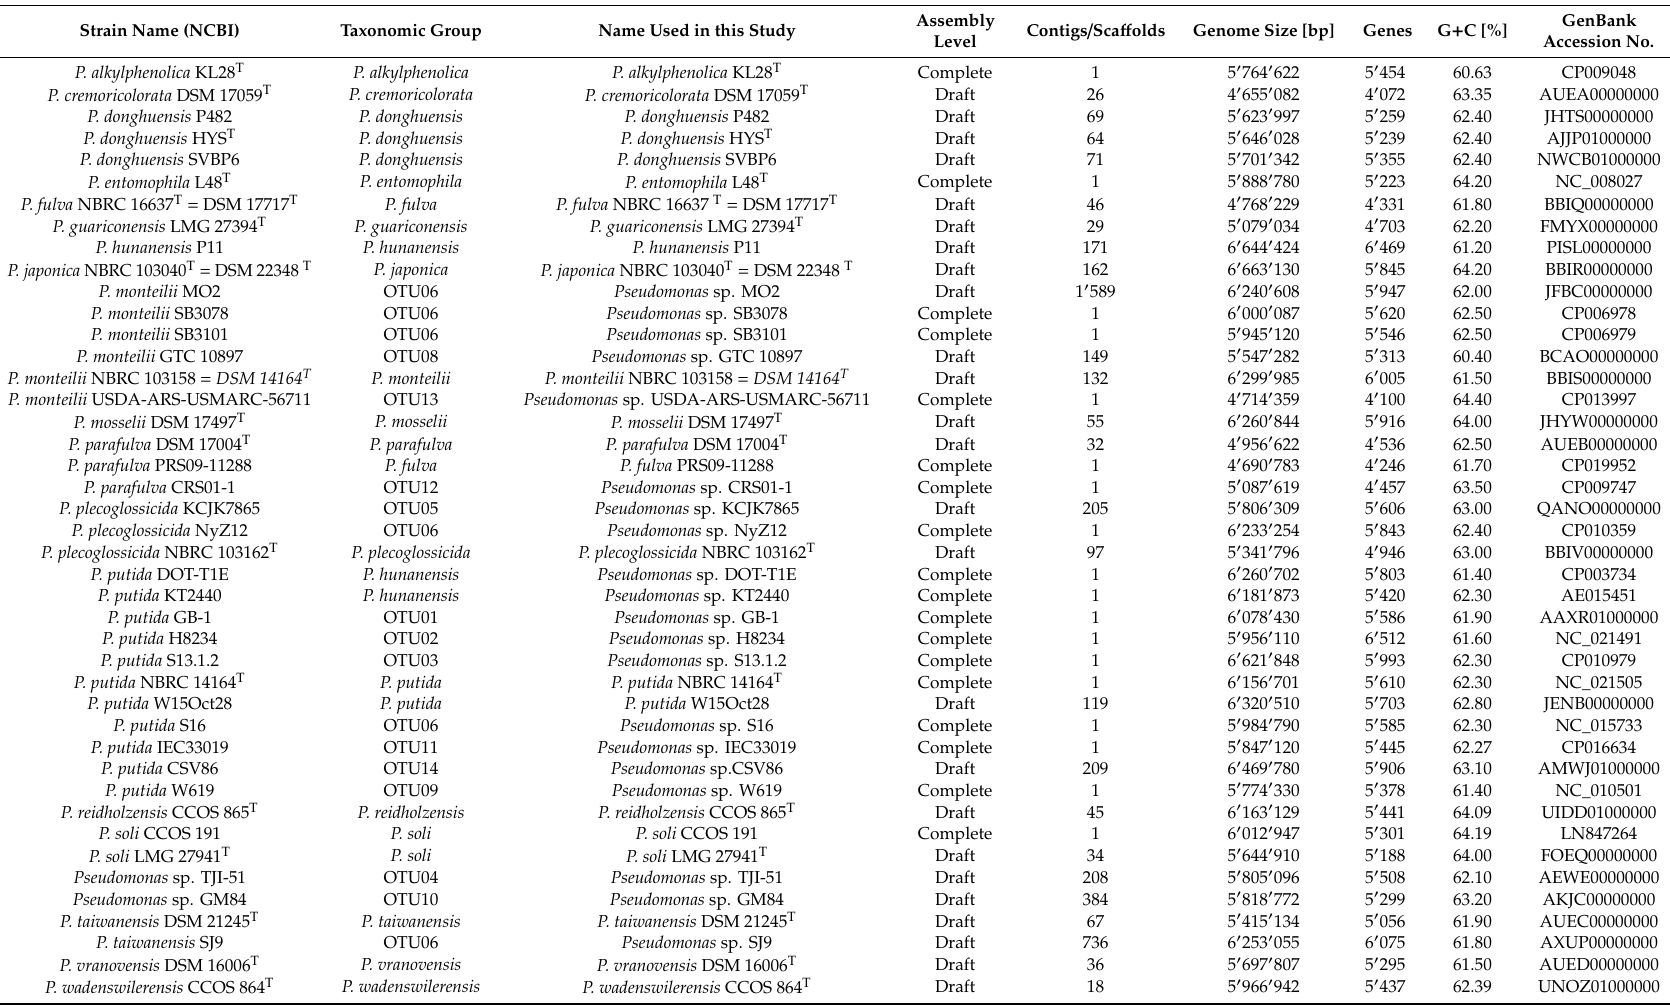
Table 1. List of bacterial strains of the Pseudomonas putida group used for comparative genomics and features of the individual genomes. Strain names labeled with “ T ” represent the type strains of this